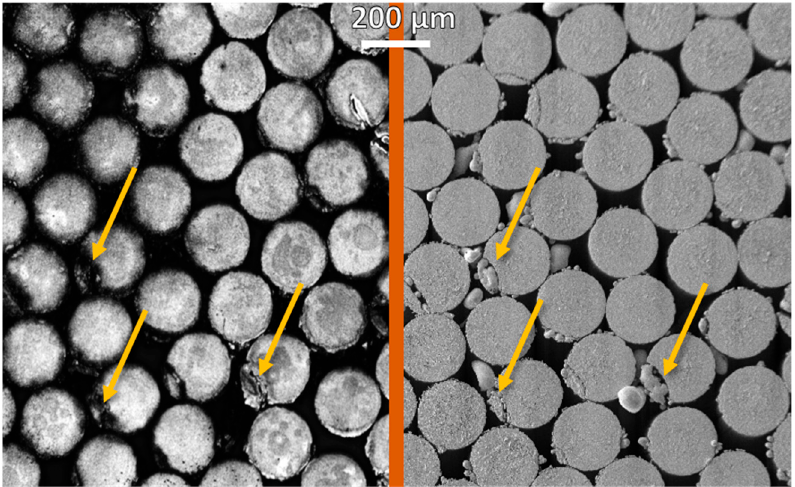
Figure 6. Comparison of the surface of the µ-brush after manufacturing (light microscope: leftside) and after 10 5 transients (SEM image: rightside). All broken wires were damaged before the high- heat-flux loading (e.g., marked by arrows).